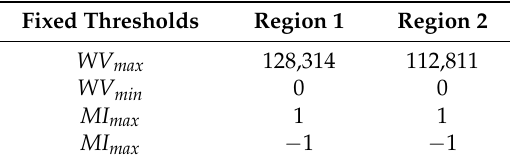
Table 1. Absolute maximum and minimum values for the two ROI for the FT method.